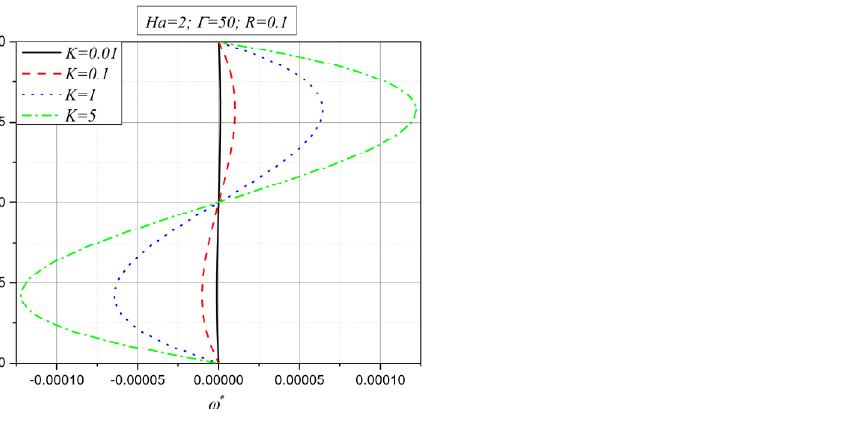
Figure 5. Influence of coupling parameter 𝐾 on velocity 𝑢 ∗ .